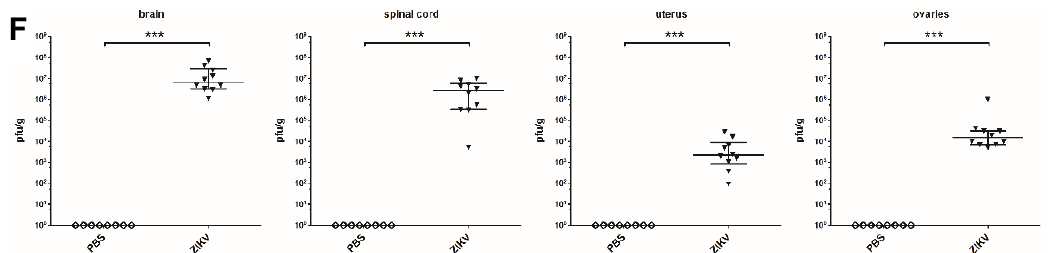
Figure 4. ZIKV induced pathology in the dams and the fetuses; ( A ) Comparative macroscopical evaluation of the uterus and individual fetuses from mock-infected control animals and ZIKV-infected animals at the end of the experiment on ED 16.5; ( B ) Representative ultrasound image of a ZIKV-infected uterus on ED 13.5 and the specific uterus of this ZIKV-infected animal on ED 16.5 at the end of the experiment; white arrow indicates fluid-filled areas which were already detected in USI at ED 13.5 and confirmed after necropsy; ( C ) Virus titers in the fetuses (fetal head) after ZIKV infection. At the end of the experiments (ED 16.5) fetal heads were removed and homogenized, and the amount of virus was determined by plaque assays ( n = 31–39 per group); data are representative of at least two independent experiments; ( D ) + ( E ) ZIKV induced changes in size and weight of the fetuses as evaluated at the end of the experiment; data are representative of at least two independent experiments; ( F ) Virus titers in maternal organs (brain, spinal cord, uterus, ovaries) after ZIKV infection. At the end of the experiments (ED 16.5) organs were removed and homogenized, and the amount of virus was determined by plaque assays ( n = 8–10 per group). Figure 4C–F: di ff erences between individual groups were analyzed by Mann–Whitney test. Error bars indicate the interquartile range (IQR) from the median. Asterisks represent statistically significant di ff erences between two groups: *** p = 0.0001, **** p < 0.0001; and data are representative of at least two independent experiments .